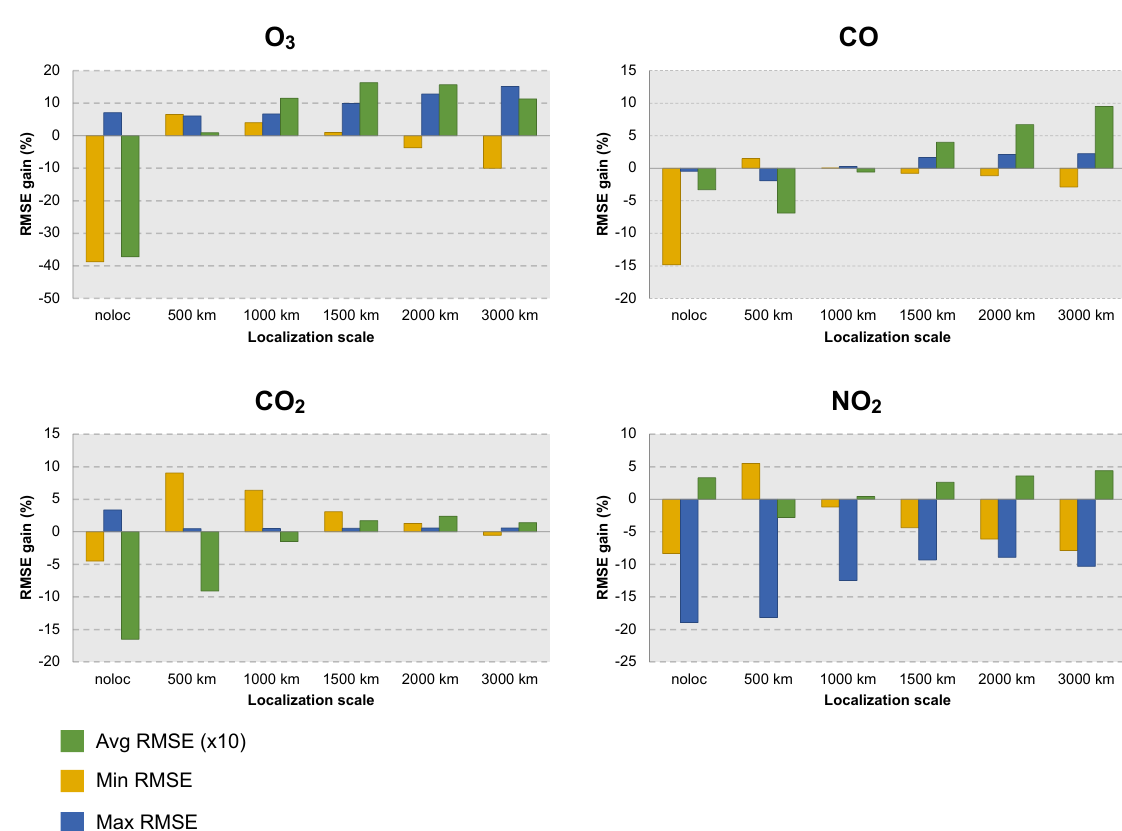
Figure 6. Same as Fig. 5 but for the horizontal length scale of the localization operator (“noloc” when no localization is